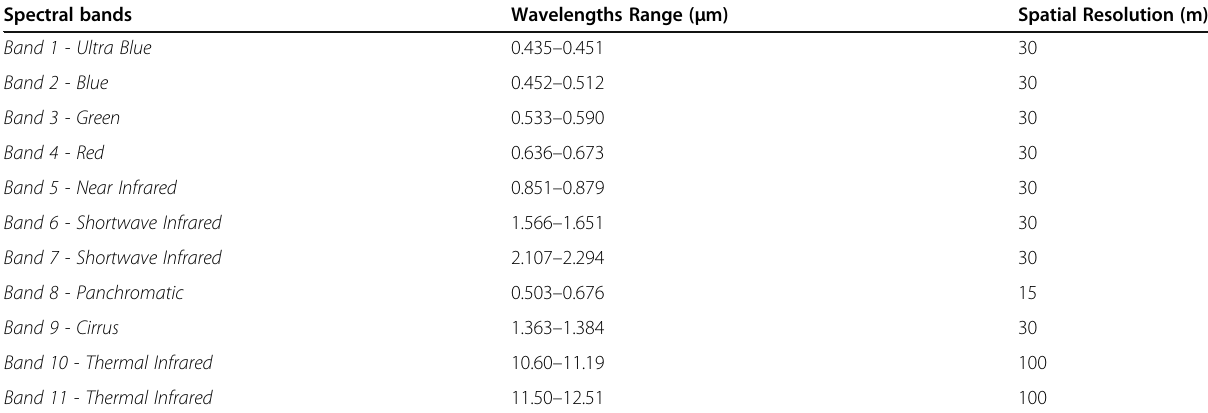
Table 1 Landsat OLI-TIRS bands characteristic Spectral